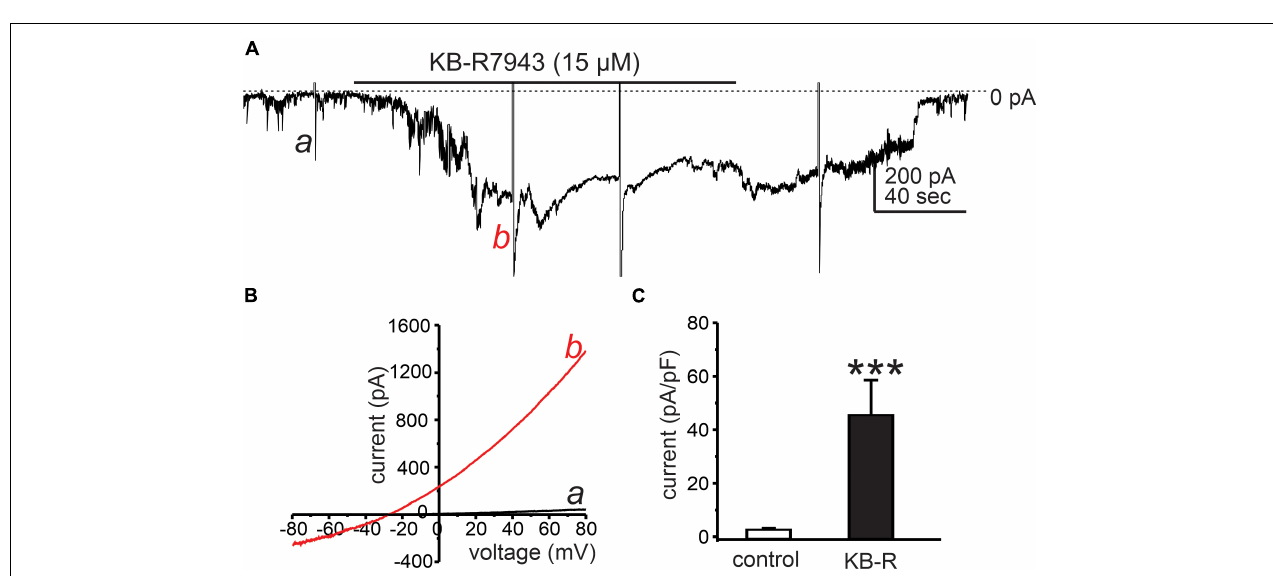
FIGURE 2 | Cl − conductance activated by KB-R7943. (A) Cells were dialyzed with internal solution ( E Cl = –40 mV, Solution VI in Table 2 ) and held at –50 mV. KB-R7943 (15 µ M) activated inward current. Ramp potentials from –80 to +80 mV were applied before (example a in the trace) and after (example b in the trace) addition of KB-R7943 (15 µ M). (B) Shows current responses to ramp potentials (a: controls, black trace in the panel) and b: KB-R7943 (15 µ M), red trace in each panel). Data taken from traces in panel A . The currents activated by KB-R7943 (15 µ M) were outwardly rectifying and reversed at E Cl . (C) Summarized data show average normalized currents (currents density, pA/pF) at 0 mV before (control) and after KB-R7943 (15 µ M; n = 5). *** p < 0.001.